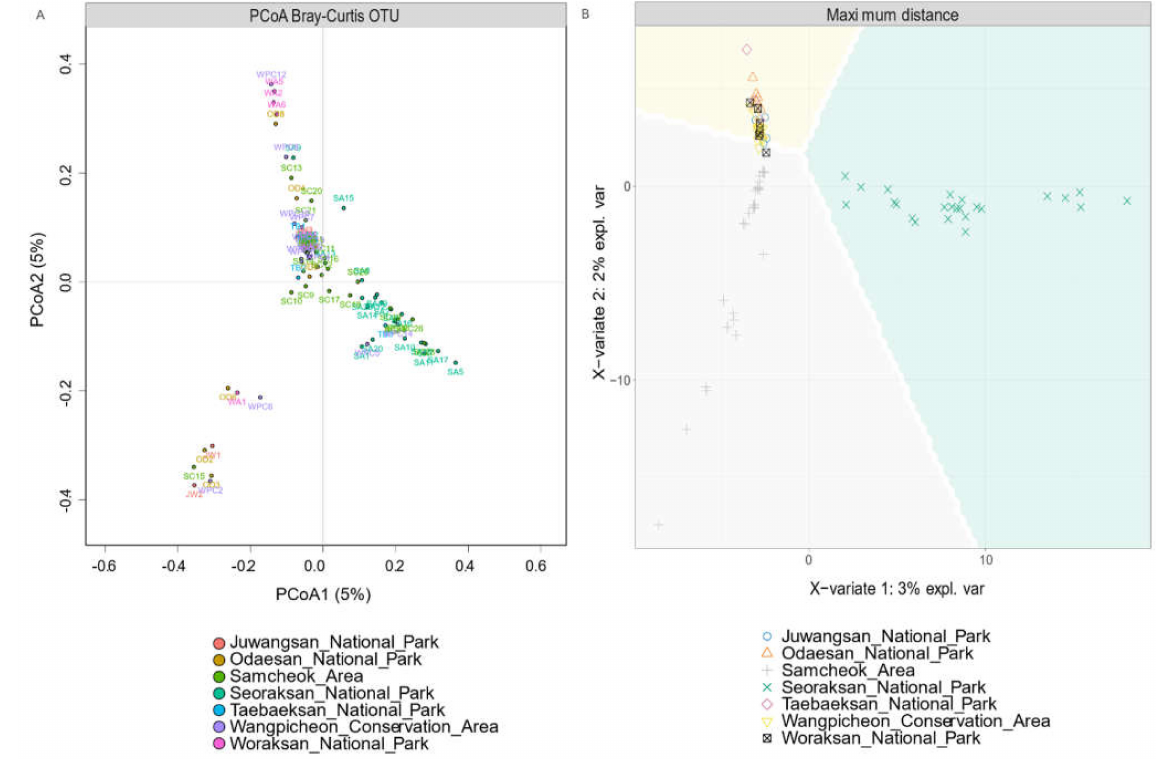
Figure 4. ( A ) Principal Coordinate Analysis using Bray − Curtis distances. Abbreviations: JW = Juwangsan National